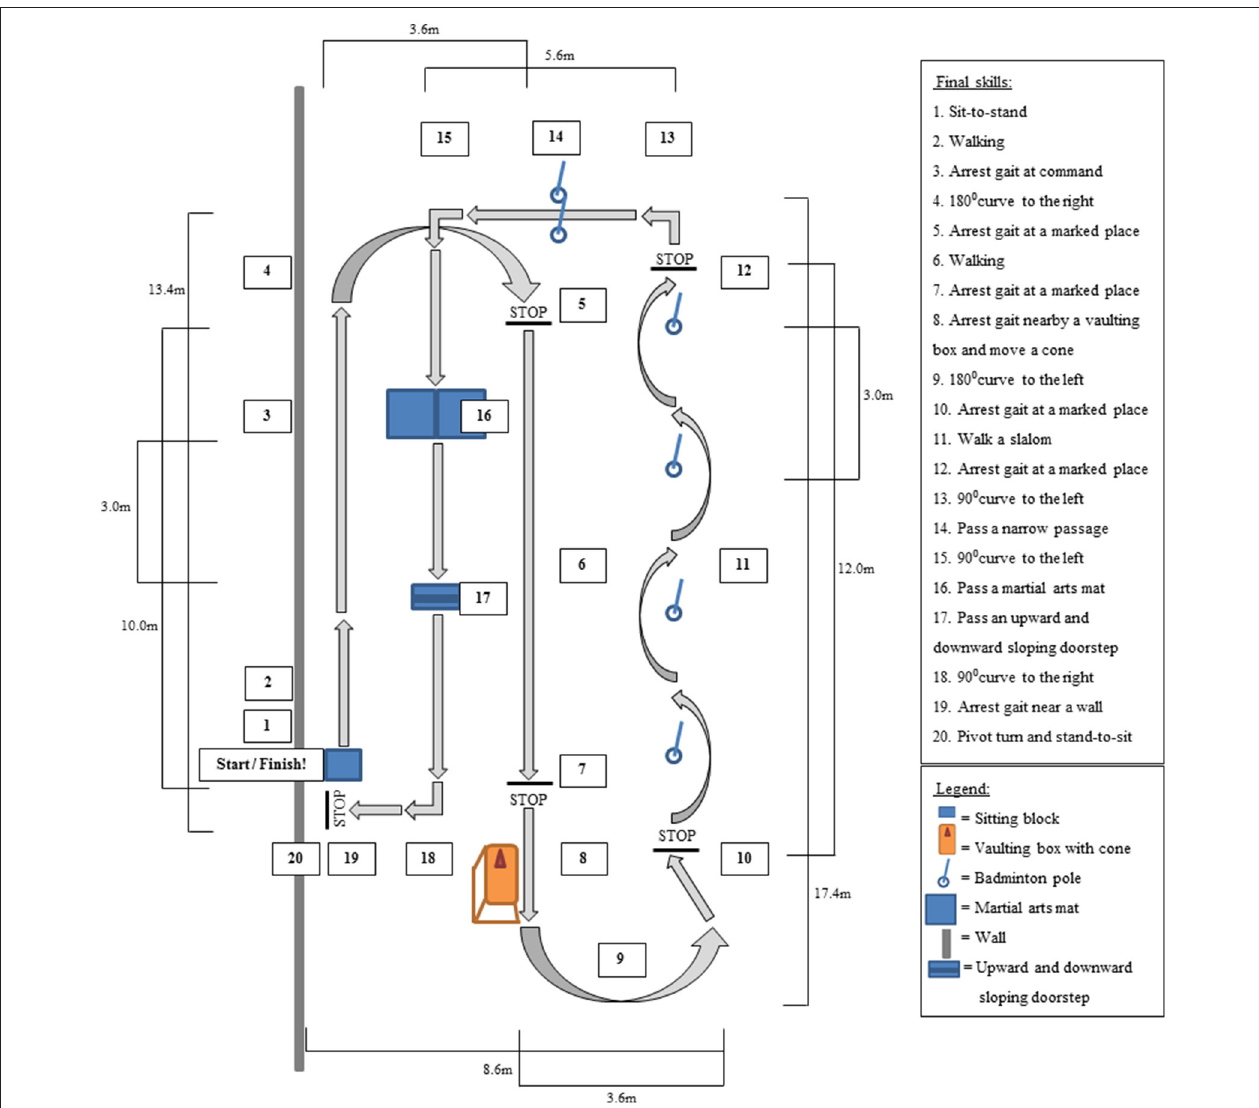
FIGURE 1 | Schematic representation of the top view of the Final-skills-test. Arrows represent the walking direction.